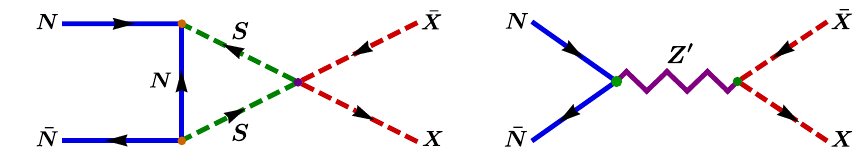
Figure 4 . The N ¯ N → X ¯ X process through the one-loop and Z 0 -mediated tree diagrams.